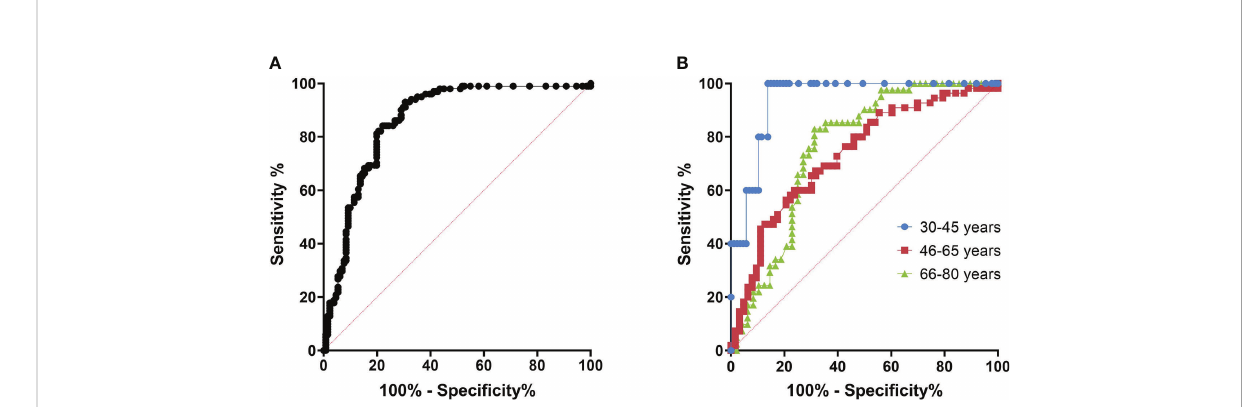
FIGURE 4 ROC curves for determining the cut off at which it is possible to predict viral neutralizing activity. (A) – All age cohorts, n = 299, AUC = 0.833 (95% CI: 0.787 - 0,880), p <0.001; (B) – With division by age/Blue – 30-45 years old ( n =92), AUC = 0.940 (95% CI: 0.879 – 1.000), p =0.001; Red – 46-65 years old ( n =118), AUC=0.734 (95% CI: 0.643 – 0.824), p <0.001; Green – 66-80 years old ( n =89), AUC=0.759 (95% CI: 0.658 – 0.860), p